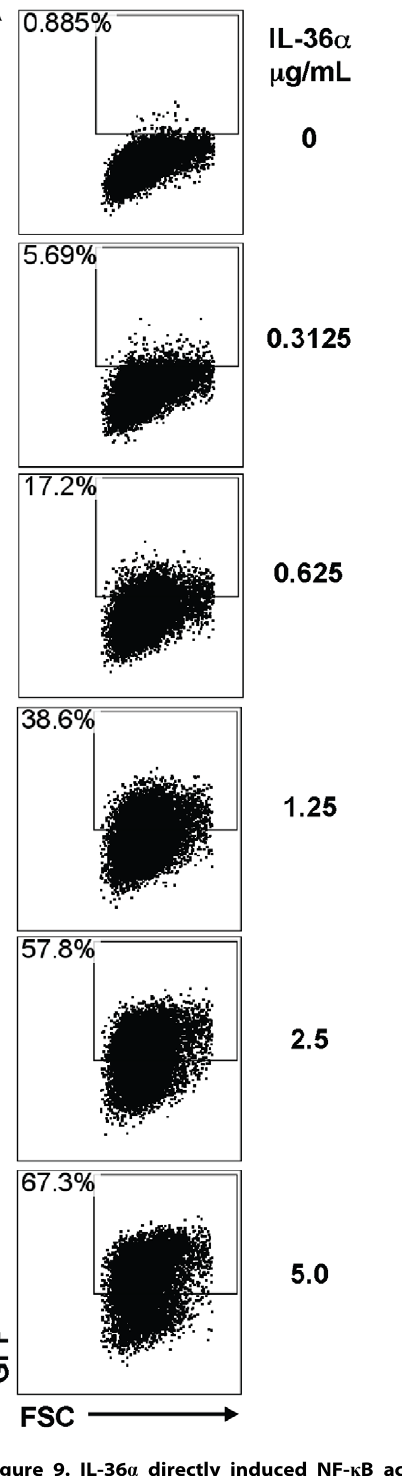
Figure 9. IL-36 a directly induced NF- k B activation in mouse macrophage cell lines. A) Cells from a mouse macrophage NF- k B reporter cell line (RAW-ELAM cells) were stimulated with increasing concentrations of IL-36 a . Green fluorescent protein (GFP) expression, indicative of NF- k B activation, was increased in a dose-dependent manner upon incubation with IL-36 a . Flow cytometry plot presented is representative of triplicate samples in one out of two independent